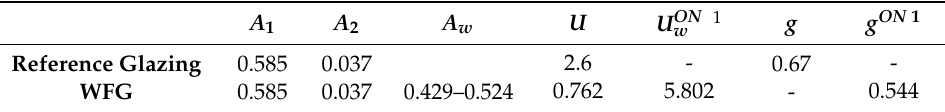
Table 1. Thermal and spectral properties of